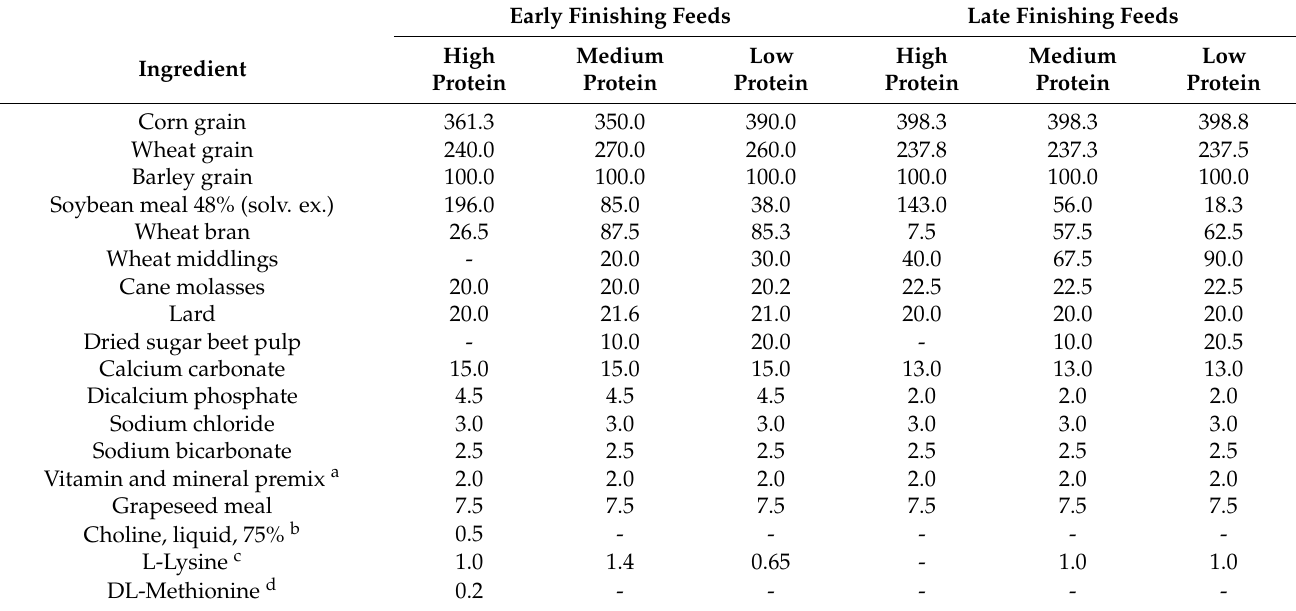
Table 2. Ingredient composition (g/kg as-fed) of early (90 to 120 kg average body weight) and late finishing feeds (over 120 kg body weight). Early Finishing Feeds Late Finishing Feeds